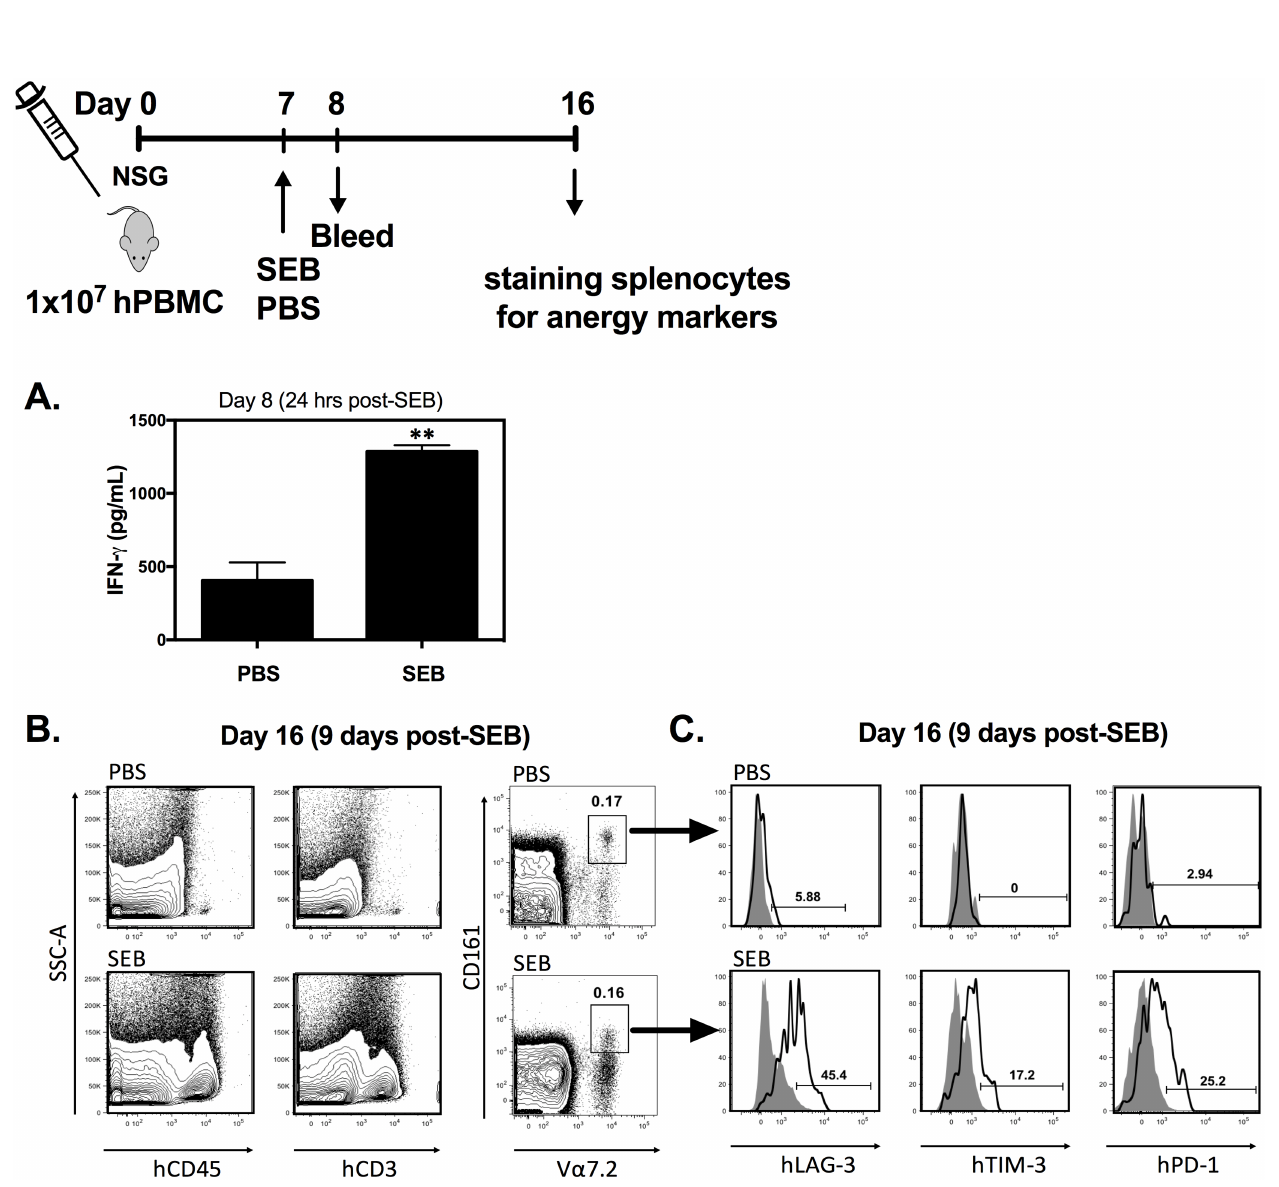
Fig 11. Staphylococcal enterotoxin B (SEB) induces rapid expression of LAG-3, TIM-3 and PD-1 by human mucosa-associated invariant T (MAIT) cells in vivo. Human peripheral blood mononuclear cell—reconstitutedNOD- scid IL-2R γ null (hPBMC-NSG) mice ( n = 3/ group) were injected with PBS or 100 μ g SEB. Twenty-four hours later, human interferon (IFN)- γ was measuredin the serum by ELISA. Error bars representSEM, and ** denotes p < 0.01 ( A ). Nine days after SEB injection,spleniccells were stained with anti-human CD45, CD3, CD161,and V α 7.2 monoclonal antibodies(mAbs) to confirm the presenceand/or expansion of human hematopoietic cells, T cells and MAIT cells in hPBMC-NSG mice ( B ). In addition,MAIT cells were assessed for surface expressionof human LAG-3, TIM-3 and PD-1 (open histograms). Filled histogramsrepresent background stainingwith isotype controls ( C ). The underlying data for this figure can be found in S1 Data, and our gating strategies are provided in S2 Data.